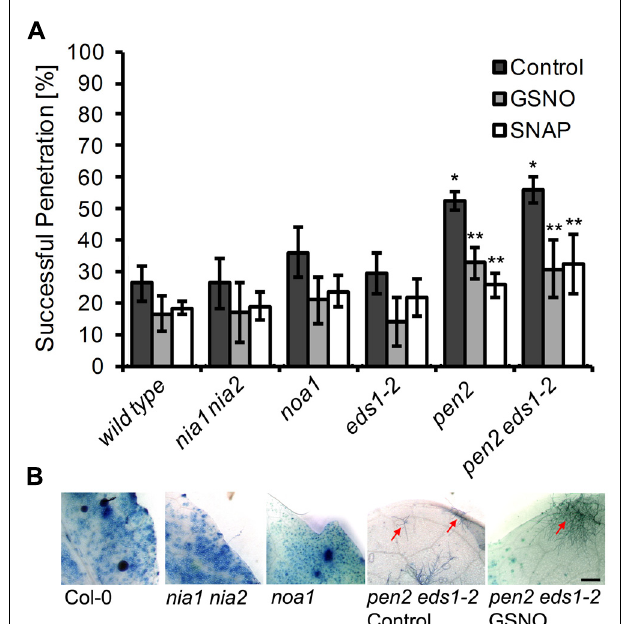
FIGURE 5 | Disease resistance phenotype of different Arabidopsis mutants to infection with Erysiphe pisi . (A) Quantitative analysis of host cell entry (penetration rates), determined 48 h post-inoculation with Erysiphe pisi (black bars).The same analysis was carried out with leaves that were infiltrated with NO donors, 200 μ M GSNO (gray bars) or 100 μ M SNAP (white bars) 2 h prior to inoculation with E. pisi spores. Data represent the mean ( ± SD) of at least six leaves taken from two different plants. One asterisk indicates a significant difference ( p < 0.01) between mutant and wild type plants, two asterisks indicates a significant difference ( p < 0.01) between control and NO donor treatment. (B) Representative micrographs of infected leaves, harvested at 7 days post-inoculation, following staining with Coomassie Brilliant Blue to visualize fungal structures and host cells that have undergone HR cell death.The Arabidopsis mutant noa1 and the double mutant nia1 nia2 show no phenotypic difference to wild type plants (Col-0), whereas the double mutant pen2 eds1-2 shows a lower frequency of HR cell death and sporadic microcolony formation (red arrow), which is not affected by pre-treatment with GSNO/SNAP. Bar = 1 mm.